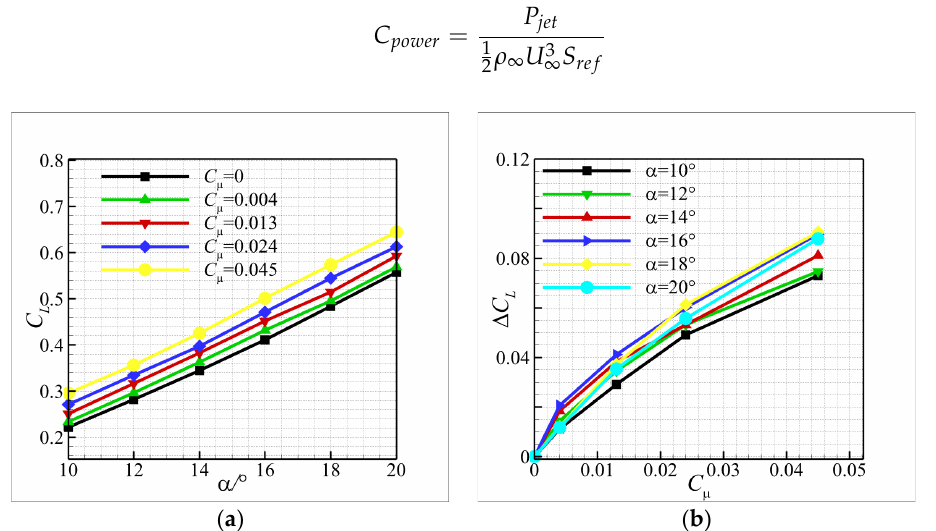
Figure 15. Changes in lift by the lateral jets with different jet momentum coefficients. ( a ) Lift coefficient; ( b ) Lift coefficient augmentation.